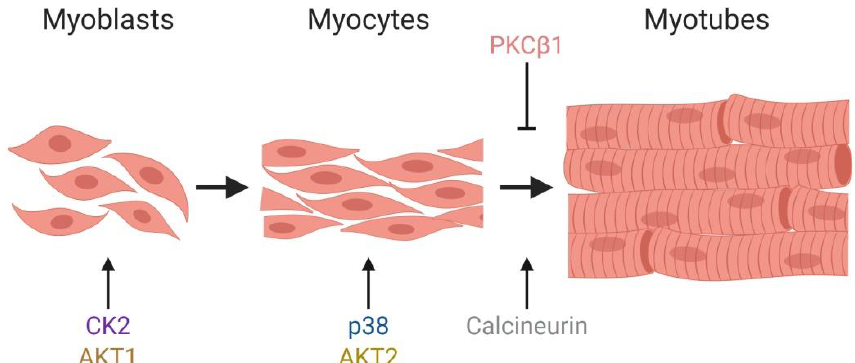
Figure 4. Kinases and phosphatases that modulate the chromatin remodeling activity of the mSWI / SNF complex during myogenesis. Schematic representation of post-natal myogenesis and indications of when specific kinases and phosphatases that control the activity of the mSWI / SNF complex act.